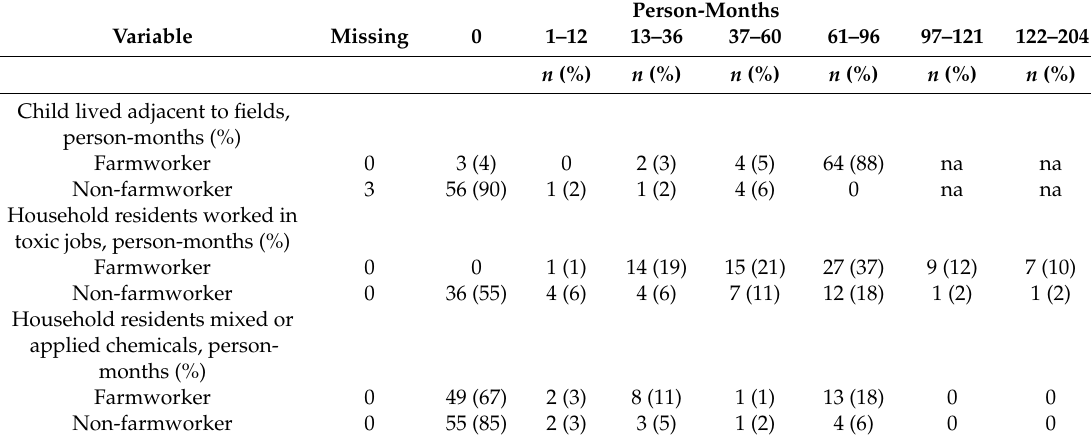
Table 3. Later childhood (36–96 months) exposure to pesticides and other toxic chemicals, comparing number and non-missing percentages for person-month ranges, by children in farmworker ( n = 73) and non-farmworker ( n = 65)